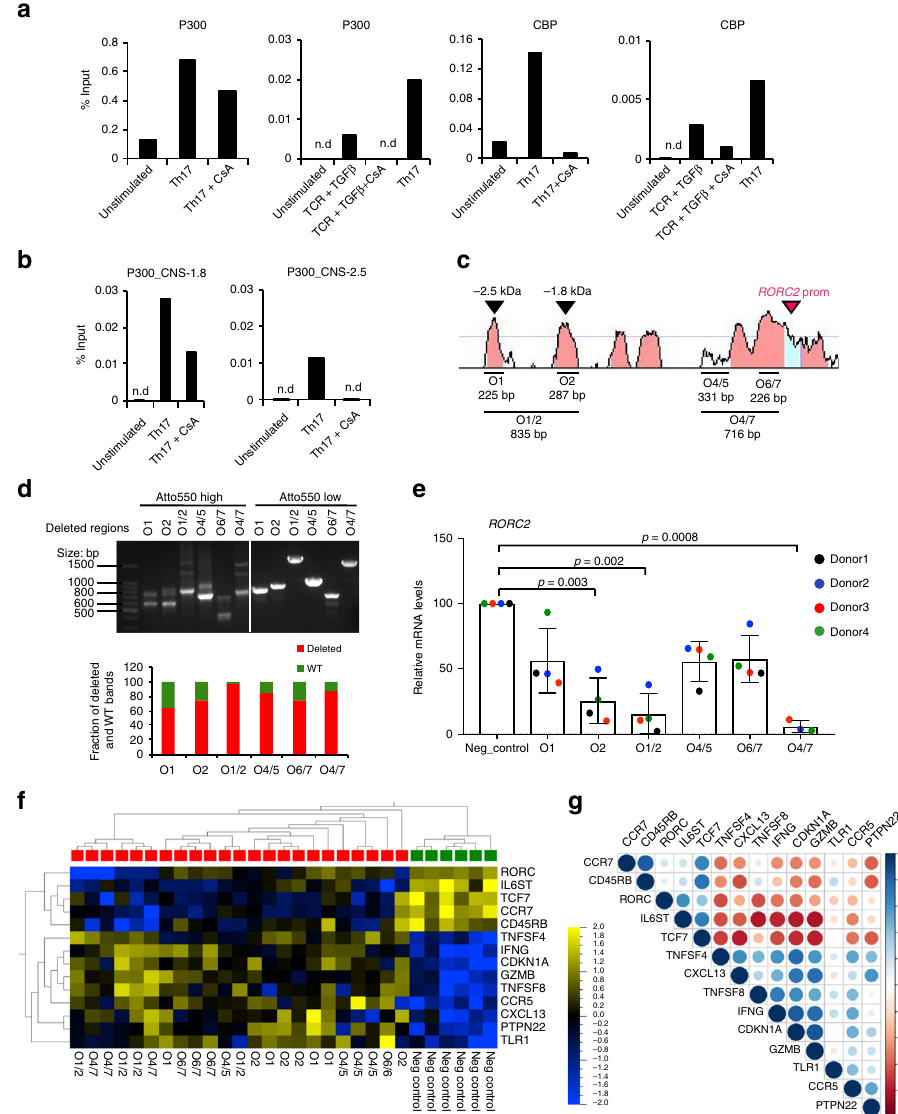
Fig. 7 Functional characterization of RORC2 regulatory regions. a , b p300 and CBP binding to the RORC locus is cyclosporine-sensitive. a p300 and CBP ChIPs were performed in CD3 + T cells from peripheral blood stimulated for 20h in the shown conditions followed by RT-qPCR of the RORC 2 promoter region. Background from an irrelevant IgG was subtracted. Shown are two representative independent ChIP experiments. Additional independent experiments are shown in Supplementary Fig. 3j, k. b p300 ChIP was performed as in A, followed by RT-qPCR of RORC2 enhancer regions. c – g CRISPR-Cas9- mediated deletion of regulatory regions in the RORC locus affects RORC 2 expression in primary CD4 + T cells. c Human/murine alignment of the RORC 2 promoter and upstream conserved region (CNS-2.5kb and − 1.8kb). The deleted regions (horizontal bars) and their sizes are represented. d Top panel: PCR ampli fi cation of genomic DNA from sorted samples (donor 3) transfected with a ribocomplex of Cas9 protein, crRNA and Atto550-labeled tracrRNA. The left side of the gel shows samples enriched for transfected cells (Atto550 High), the right side samples from Atto550 low cells, carrying wild-type DNA. Asterisks mark fragments carrying the expected deletions. Bottom panel: the proportion of WT and deleted DNA fragments in the Atto550 positive cells was quanti fi ed with ImageJ program. e Expression of RORC 2 was measured by nCounter technology in CD4 + T cells transfected with a negative control crRNA, or cells carrying a genomic deletion as shown in c , d . Horizontal bars indicate two-tailed Student t -test on samples from 4 different donors. f ANOVA analysis of gene expression Nanostring data in control and CRISPR/Cas9 deleted CD4 + T cell populations from 4 donors ( p = 0.002, q = 0.060). Donors 3 and 4 had two independent control transfections each. Green squares indicate control samples, red square samples carrying RORC 2 deletions. g Pearson correlation plot of the top differentially expressed variable from the ANOVA analysis in d . Source data are provided as a Source Data fi Deletion of CNS-2.5 and CNS-1.8 reduces RORC 2 transcription . CNS-1.8, supporting a role for NFAT in the acetylation of the enhancer region as well (Fig. 7b). The analysis of histone modi fi cations and of transcriptional reg- Taken together, these results indicate that the recruitment ulators binding suggest that the genomic regions corresponding to of NFAT proteins to the RORC locus plays a role in CNS-2.5 and CNS-1.8 may have enhancer function on RORC 2 establishing a chromatin conformation permissive for RORC 2 expression. These data, together with data from the literature transcription. (Supplementary Fig. 4 and legend), indicate that these regions are